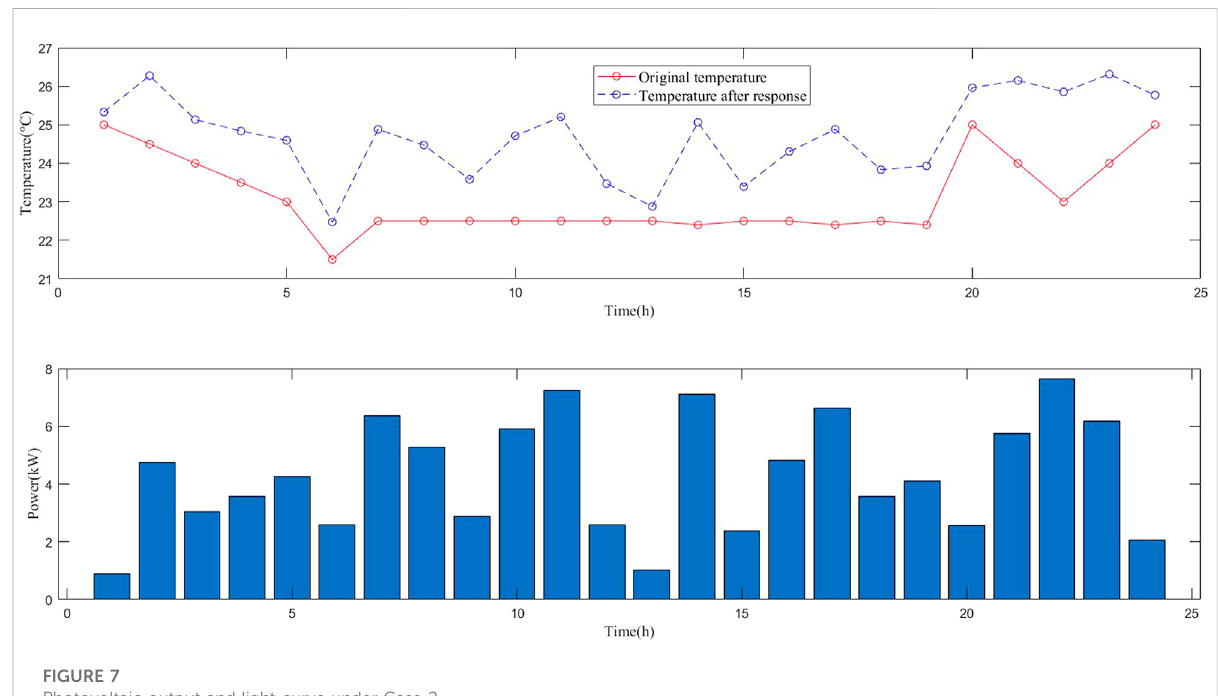
FIGURE 7 Photovoltaic output and light curve under Case 2.